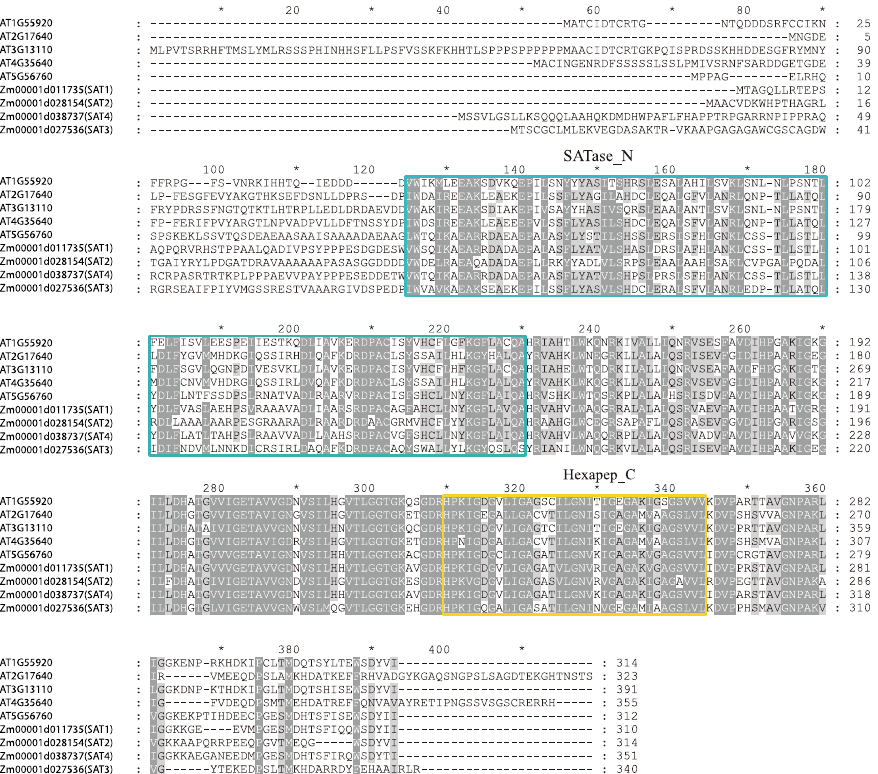
Figure 2. Amino acid sequence alignment of SAT gene family for B73 and Arabidopsis . The motifs of serine acetyltransferase (SATase_N) at the N-terminal and the C-terminal hexapeptide repeat domain (Hexapep_C) are highlighted with the blue and yellow boxes, respectively. The conserved amino acids are labeled as asterisks on top.